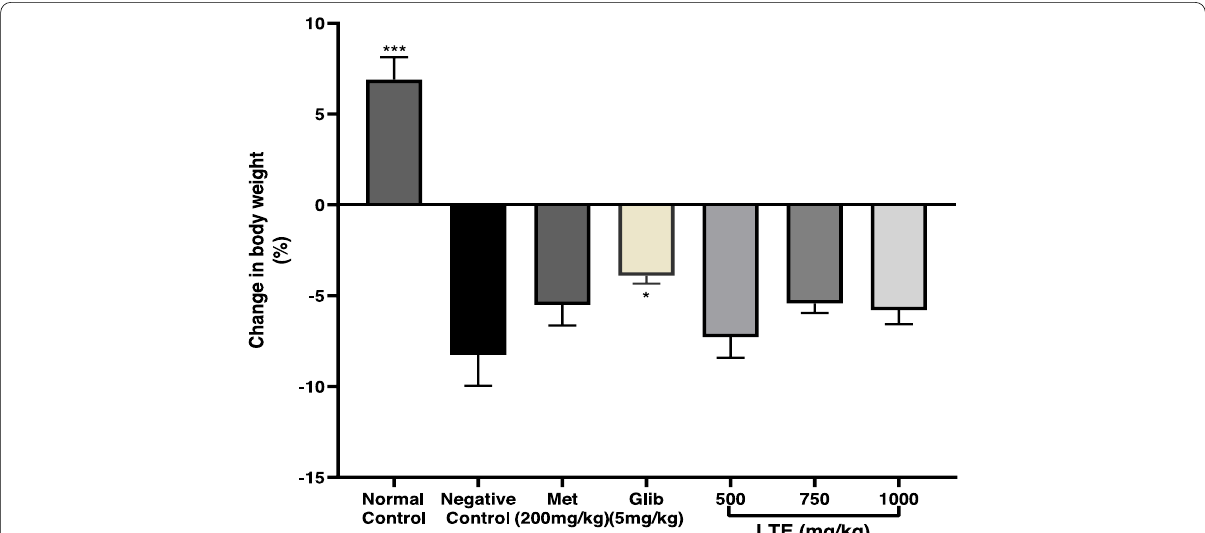
Fig. 6 Effects of LTE on rat body weight. Values were expressed as mean Dunnett’s multiple comparisons test. * represents statistical significance at p < 0.05 vs. the negative control